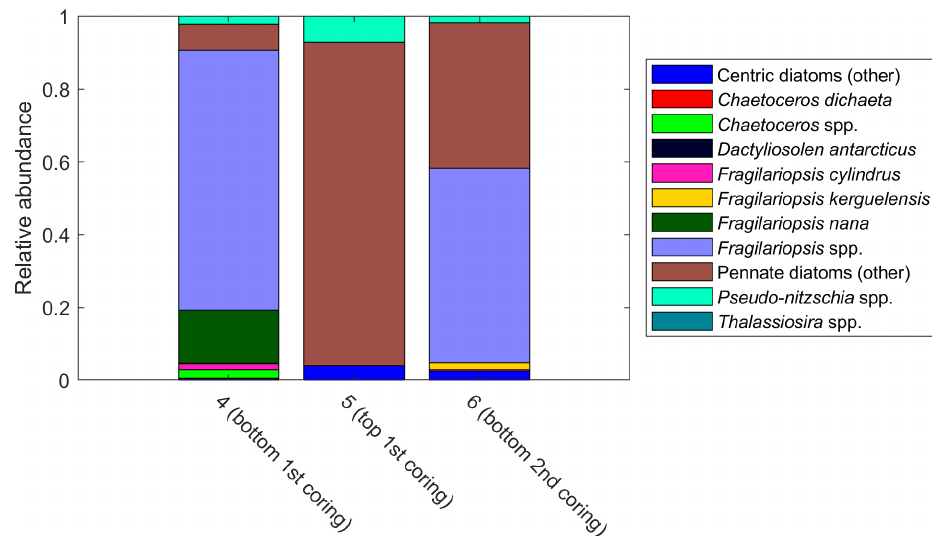
Figure A14. Relative diatom abundance in ice core samples. The colors pink to cyan comprise pennate diatoms. The bars are marked with sample numbers and ice core section explanations. See Table B2 for method descriptions.